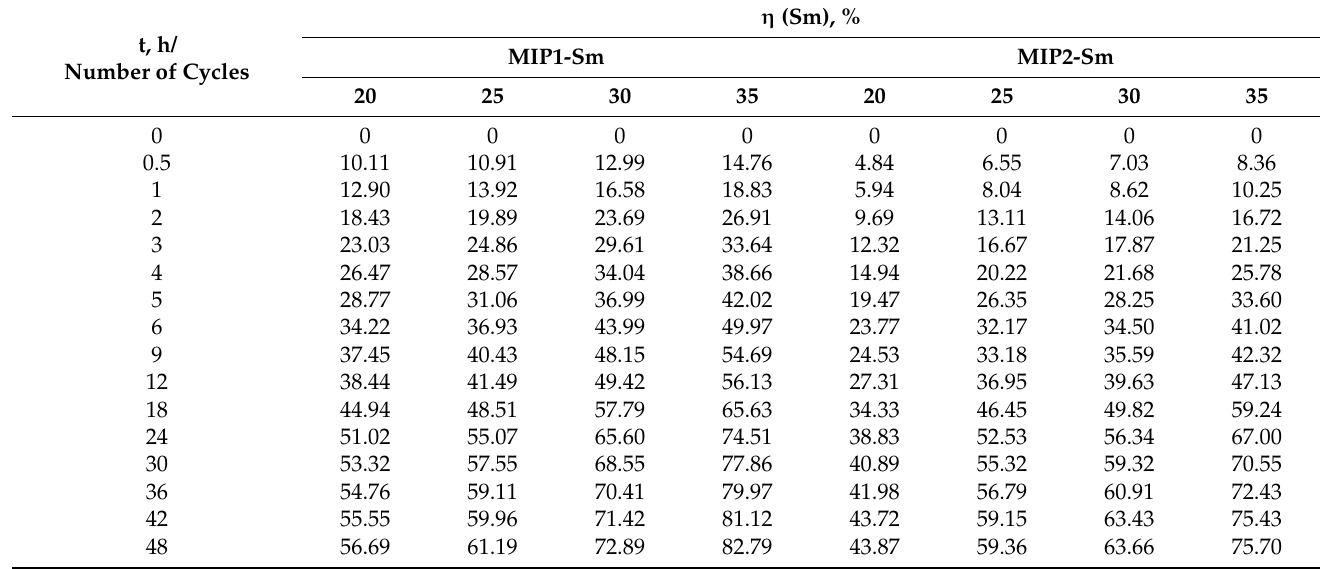
Table 4. Values of extraction degrees of samarium after certain amount of template removal cycles.